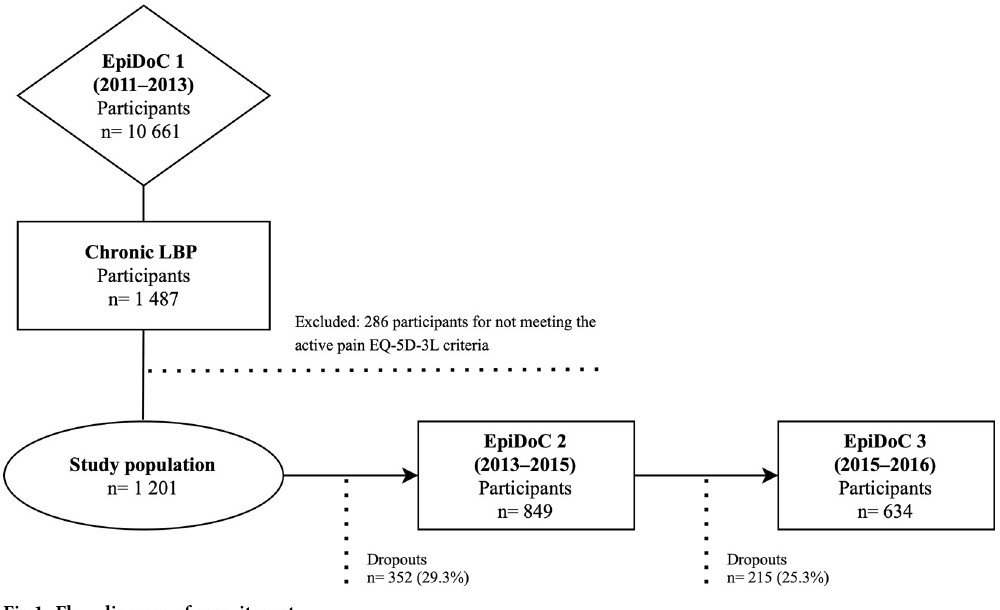
Fig 1. Flow diagram of